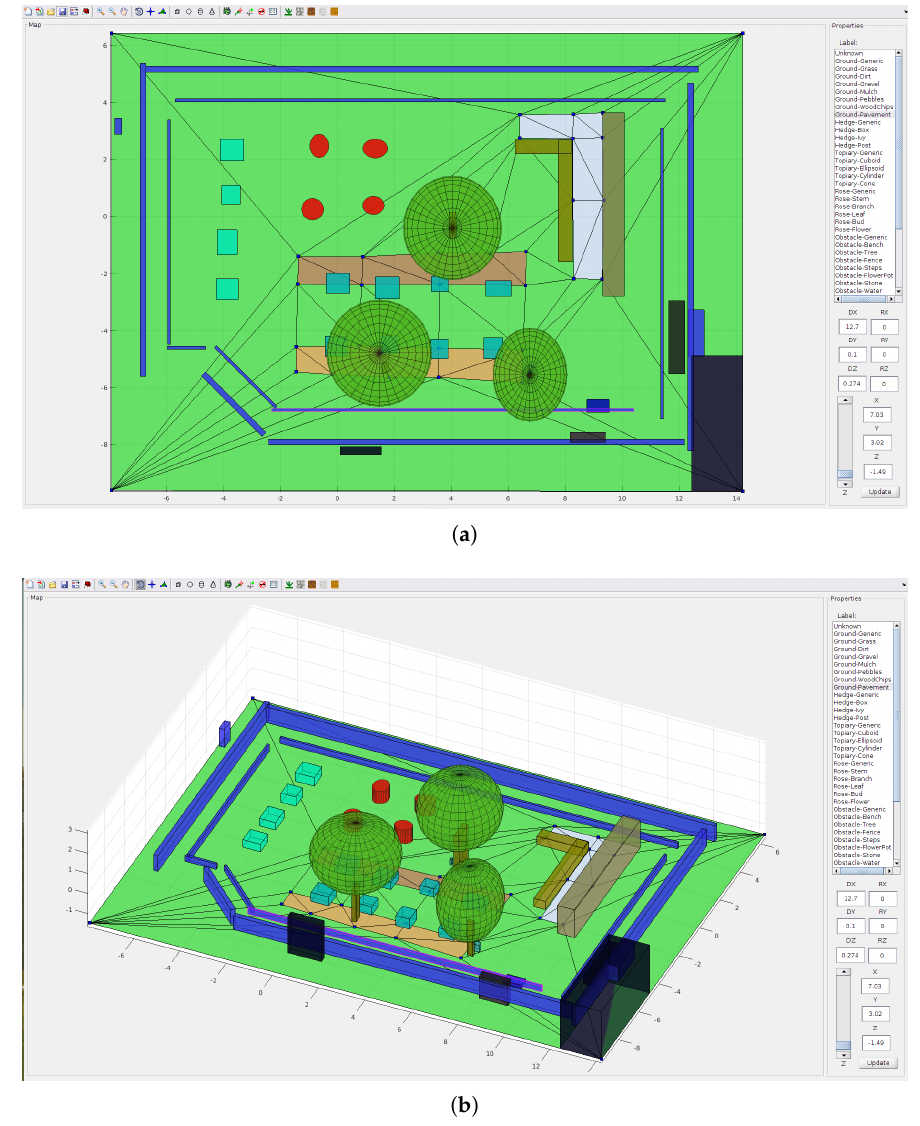
Figure 6. User interface of the 3D Map Editor with mesh of terrain and objects. Blue markers are control points of the terrain mesh. ( a ) 2D view; ( b ) 3D